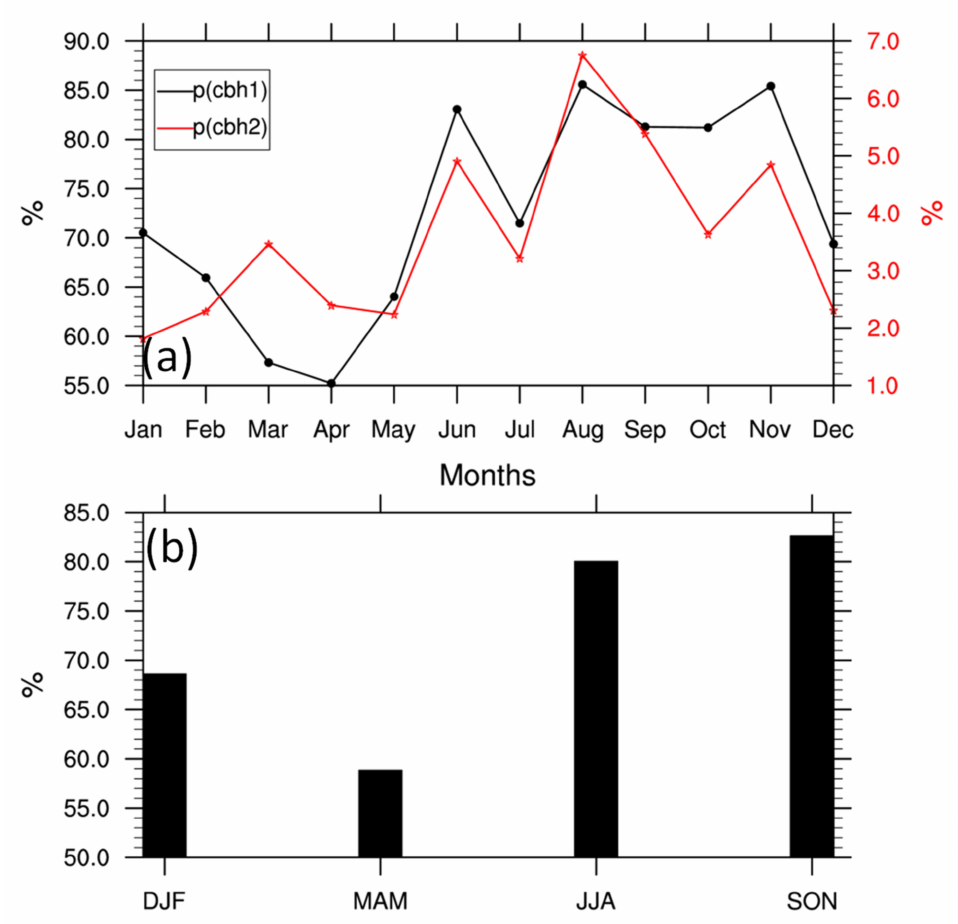
Figure 3. ( a ) Annual cycle of the cloud occurrence (black, in percentage) and probability of detection CBH2 (red line) in percentage. ( b ) Seasonal average of cloud occurrence in